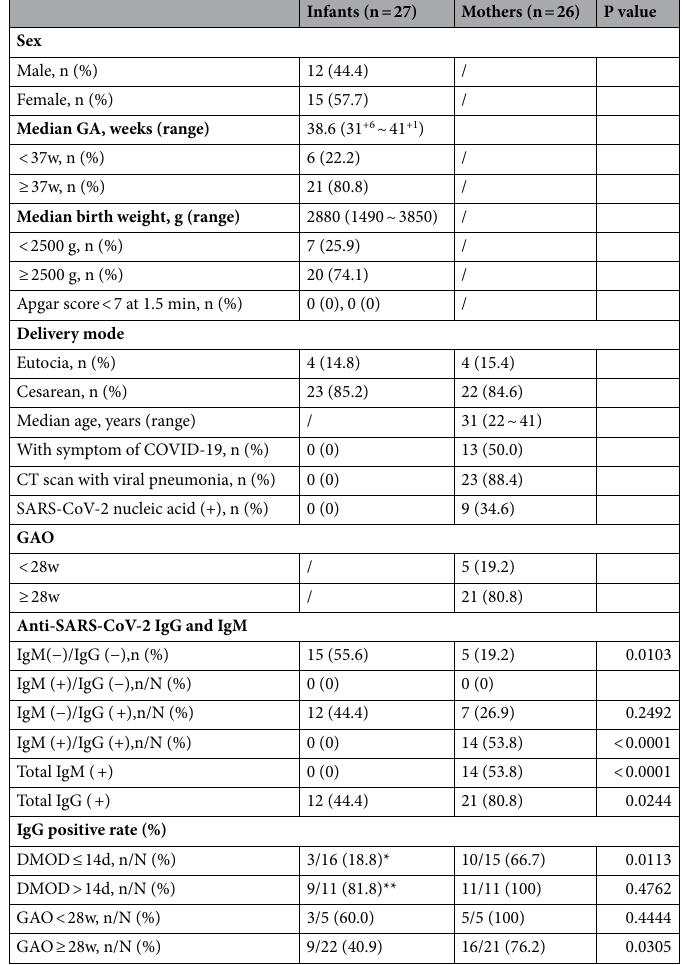
Table 1. Clinical data of mothers and infants recruited. Between * and **, p value = 0.002. n/N number of positive or negative cases/number of test cases, CT computed tomography, DMOD days from mother’s onset to delivery, GAO gestational age at onset, GA gestational